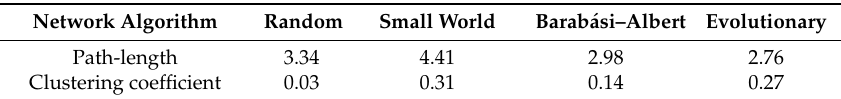
Table 2. Network characteristics.